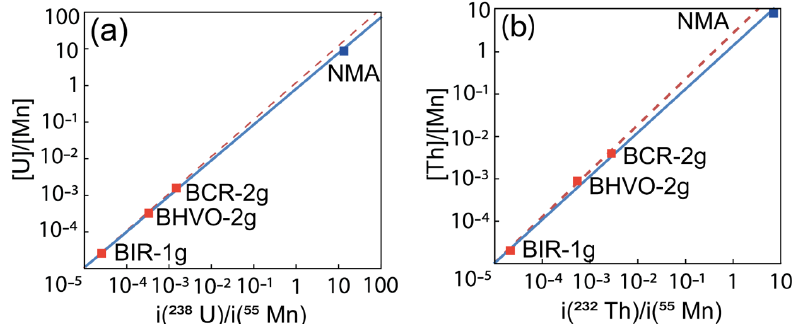
Figure 4. Calibration lines used for the calibration of the LA-ICP-MS signal. (a) U / Mn-calibration lines using silicate glass standards (dotted red line) and NMA nano-magnetite sample (blue line). (b) Th / Mn calibration lines with silicate glass standards (dotted red line) and NMA nano-magnetite sample (blue line).